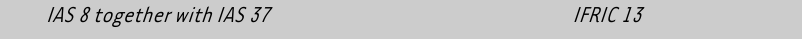
TABLE 3: IAS 8 (together with IAS 37) and IFRIC 13’s guidelines on the accounting treatment of a change in accounting